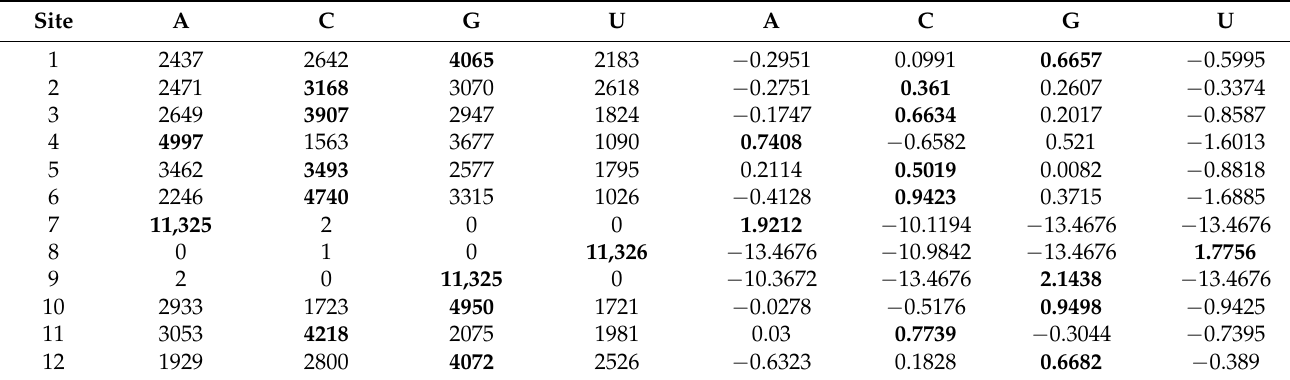
Table 5. Site-specific frequencies (columns 2–5) of 11,327 CDSs (including isoforms) in human chromosome 1 (NC_000001.11), and the position weight matrix (columns 6–9) derived from them using intron nucleotide frequencies (0.26398, 0.21777, 0.22622 and 0.29203 for A, C, G, and T, respectively) as background frequencies. Favored nucleotides are highlighted in bold. Start codons are at sites 7–9. The favored translation initiation motif is GCCACC AUG